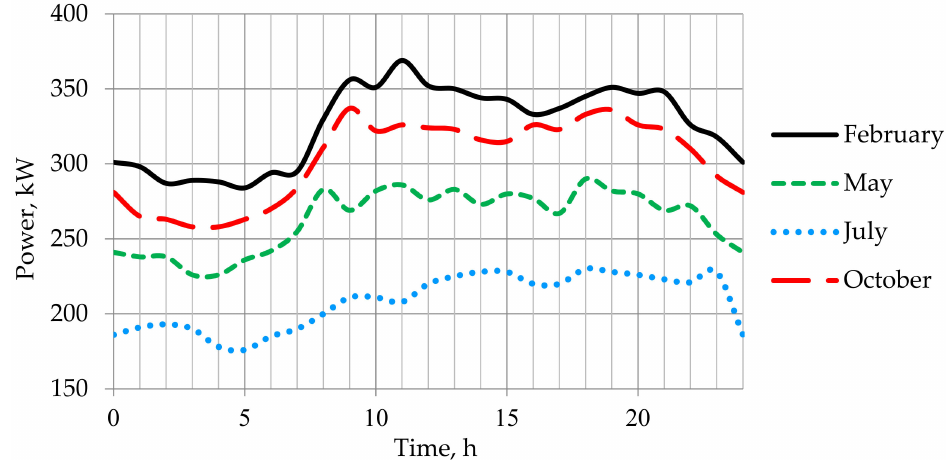
Figure 3. Daily load profile for Novikovo in February, May, July, and October. Annual wind speed and insolation profiles averaged over 1 h during one year were used as input data on the wind and solar energy potential [33]. Profiles for a longer period could be used as input data on wind and insolation, and then the proposed model